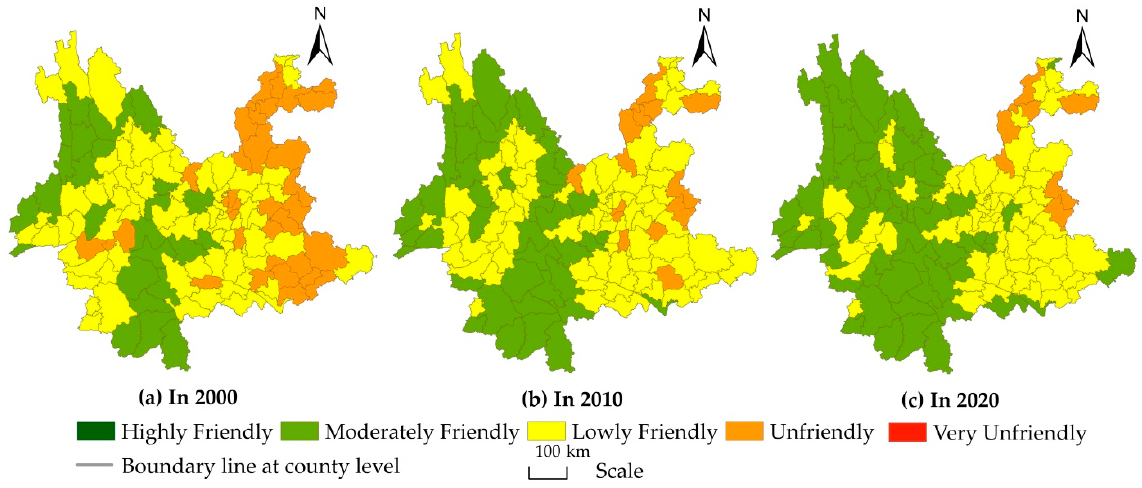
Figure 3. Ecological friendliness evaluation of land use from 2000 to 2020.